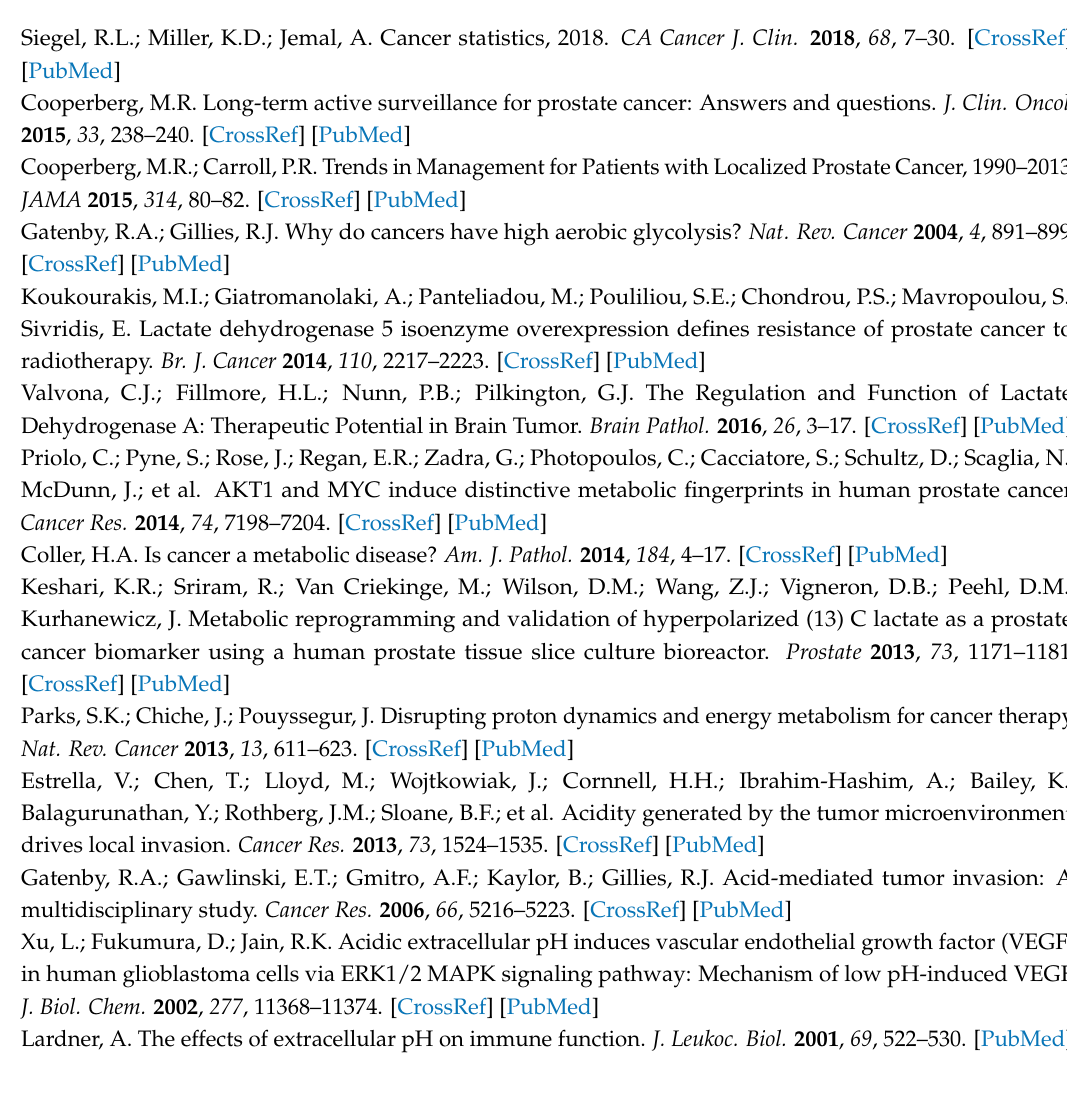
Figure S1: Western blot of LDHA gene knockdown induced by tamoxifen